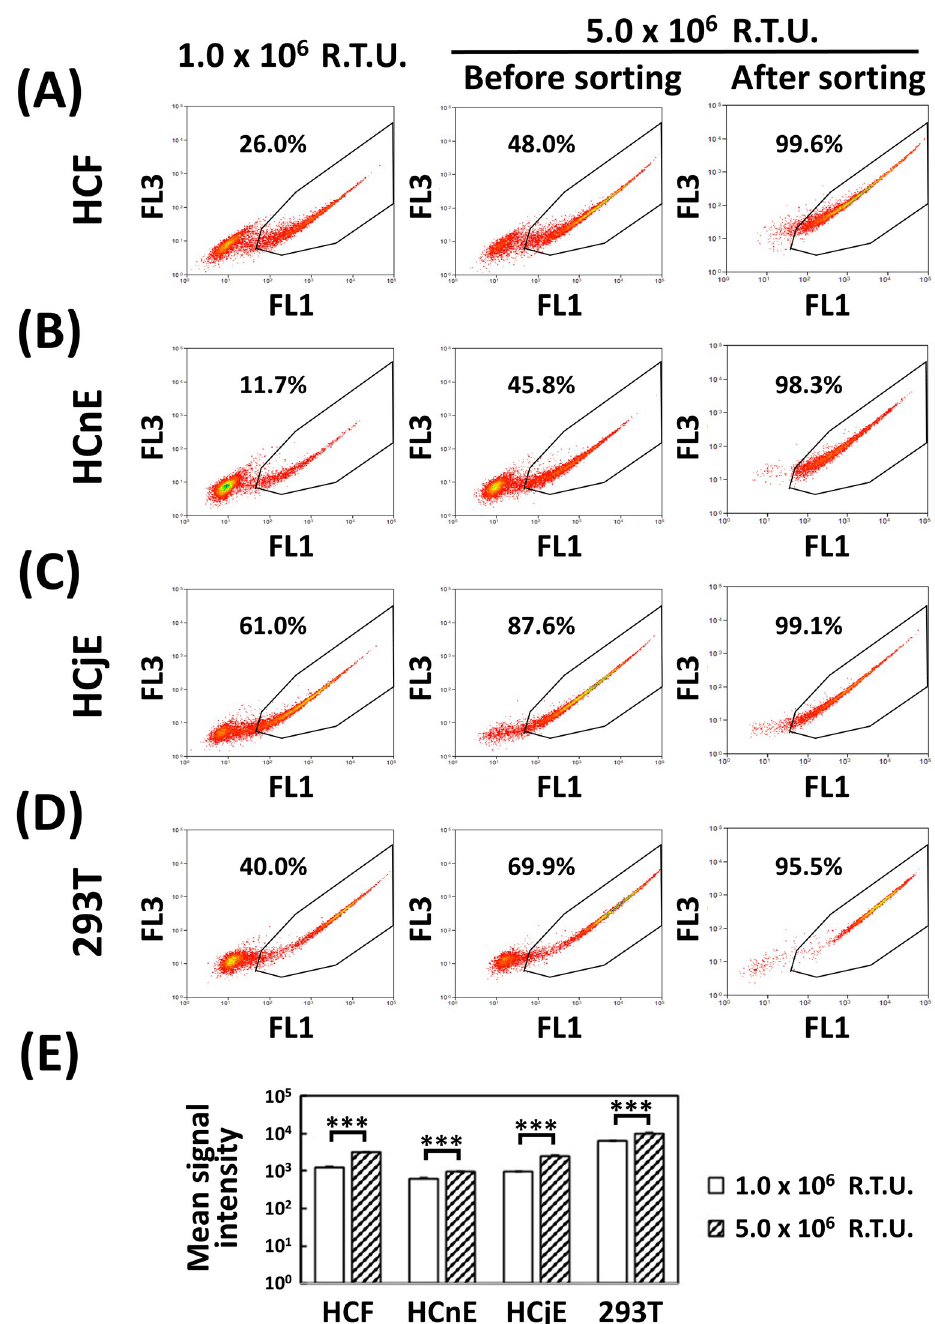
Fig 1. Differences in expression efficiency after transduction of various ocular cell types with EGFP-encoding pseudovirions. Each cell type was seeded into a 10-cm culture dish: (A) 2.0 × 10 5 HCFs, (B) 2.0 × 10 6 HCnEs, (C) 2.0 × 10 6 HCjEs, and (D) 2.0 × 10 6 HEK-293T cells. At 24 h post-seeding, each cell type was treated with EGFP- encoding pseudovirions at 1.0 × 10 6 R.T.U. or 5.0 × 10 6 R.T.U. for 16 h. Subsequently, the culture media were refreshed for all transduced cells until > 90% confluency was attained. Cell sorting was used to analyze the transduced cells with 1.0 × 10 6 R.T.U. (left panels) or 5.0 × 10 6 R.T.U. (middle panels). The right-most panels present data acquired after sorting of the cells transduced with 5.0 × 10 6 R.T.U. The percentages represent the homogeneity of EGFP-positive cells in the gating regions. (E) The mean signal intensity was the average signal intensity of the gated EGFP-positive cells in the FL1 channel (S1 Fig). The analysis of transduction of each cell type with two different titers of EGFP pseudovirions was repeated three times with similar trends. The shown data represent the results of one of the